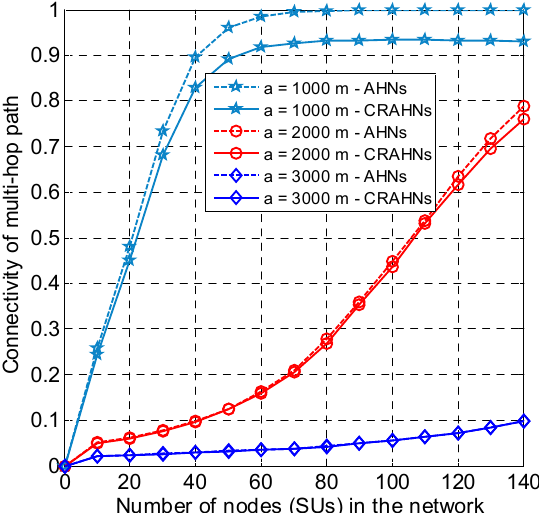
Figure 11 . The connectivity of multi-hop path in CRAHNs with different network sizes; number of PUs = 3, average active rate of PUs = 0.1, one frequency layer with operating frequency = 2.4 GHz.